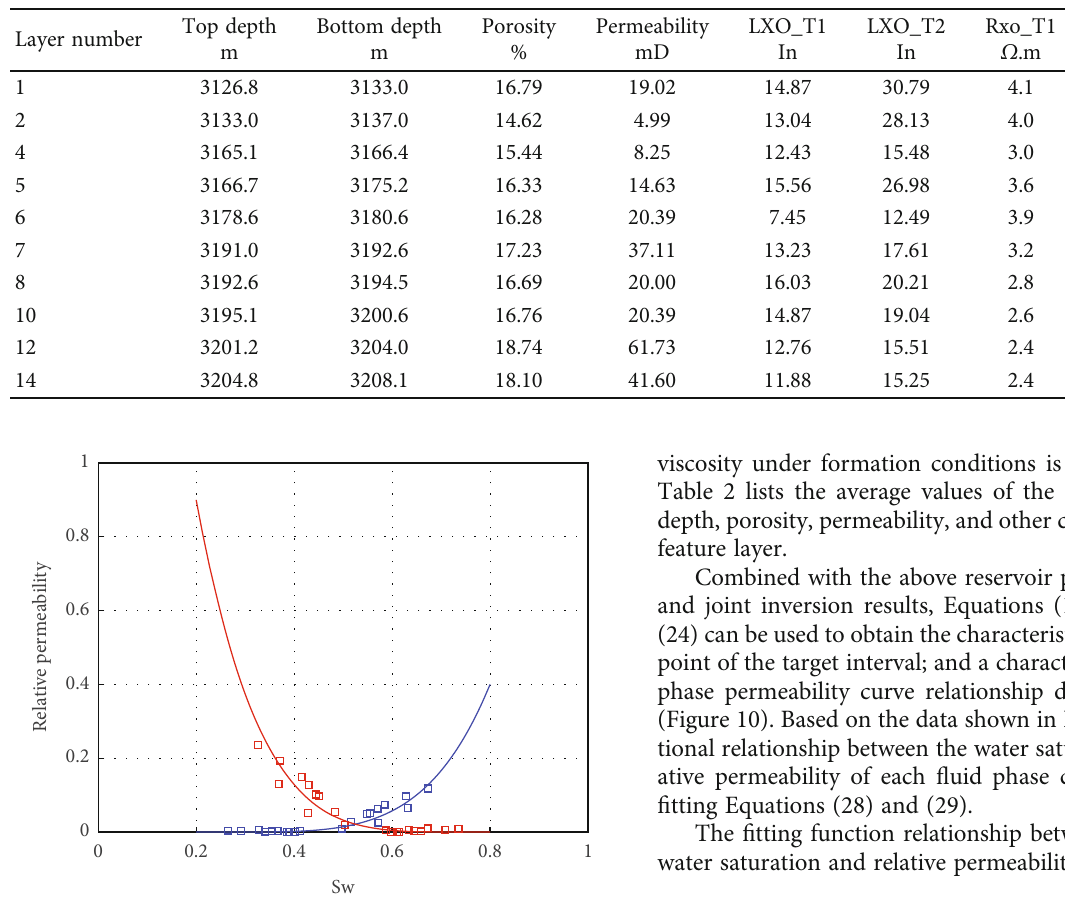
Table 2: Physical parameters and joint inversion results of the target interval.